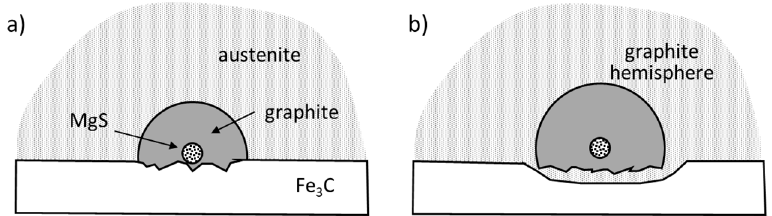
Figure 44. Mechanism of formation of graphite hemispheres: ( a ) nucleation of MgS at the Fe 3 C- γ interface; ( b ) growth of graphite through the decomposition of carbide and C migration through the austenite.